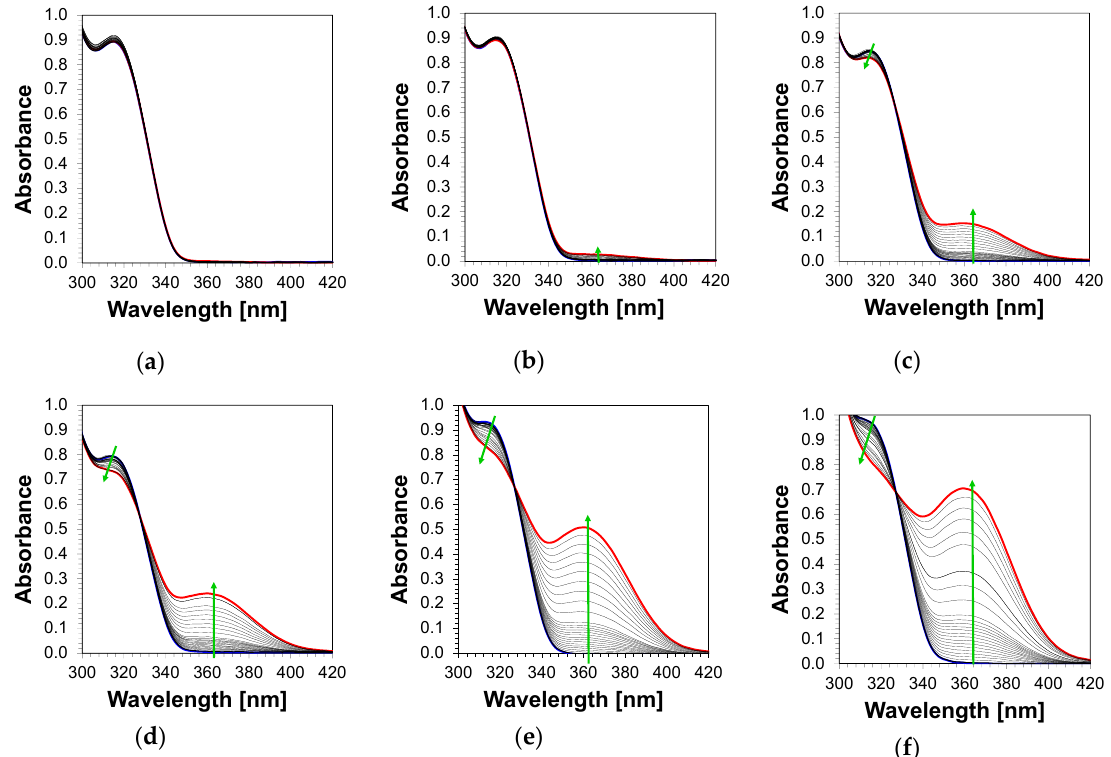
Figure 17. Photolysis of HIP / PT-OCH 3 in acetonitrile upon exposure to LED @ 320 nm (1mW / cm 2 ) in a molar ratio: ( a ) 0.5:1; ( b ) 1:1; ( c ) 5:1; ( d ) 10:1; ( e ) 20:1; ( f ) 30:1.